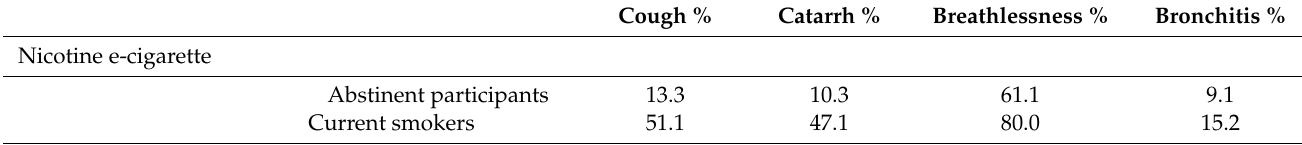
Table 2. Respiratory symptoms at month 12.